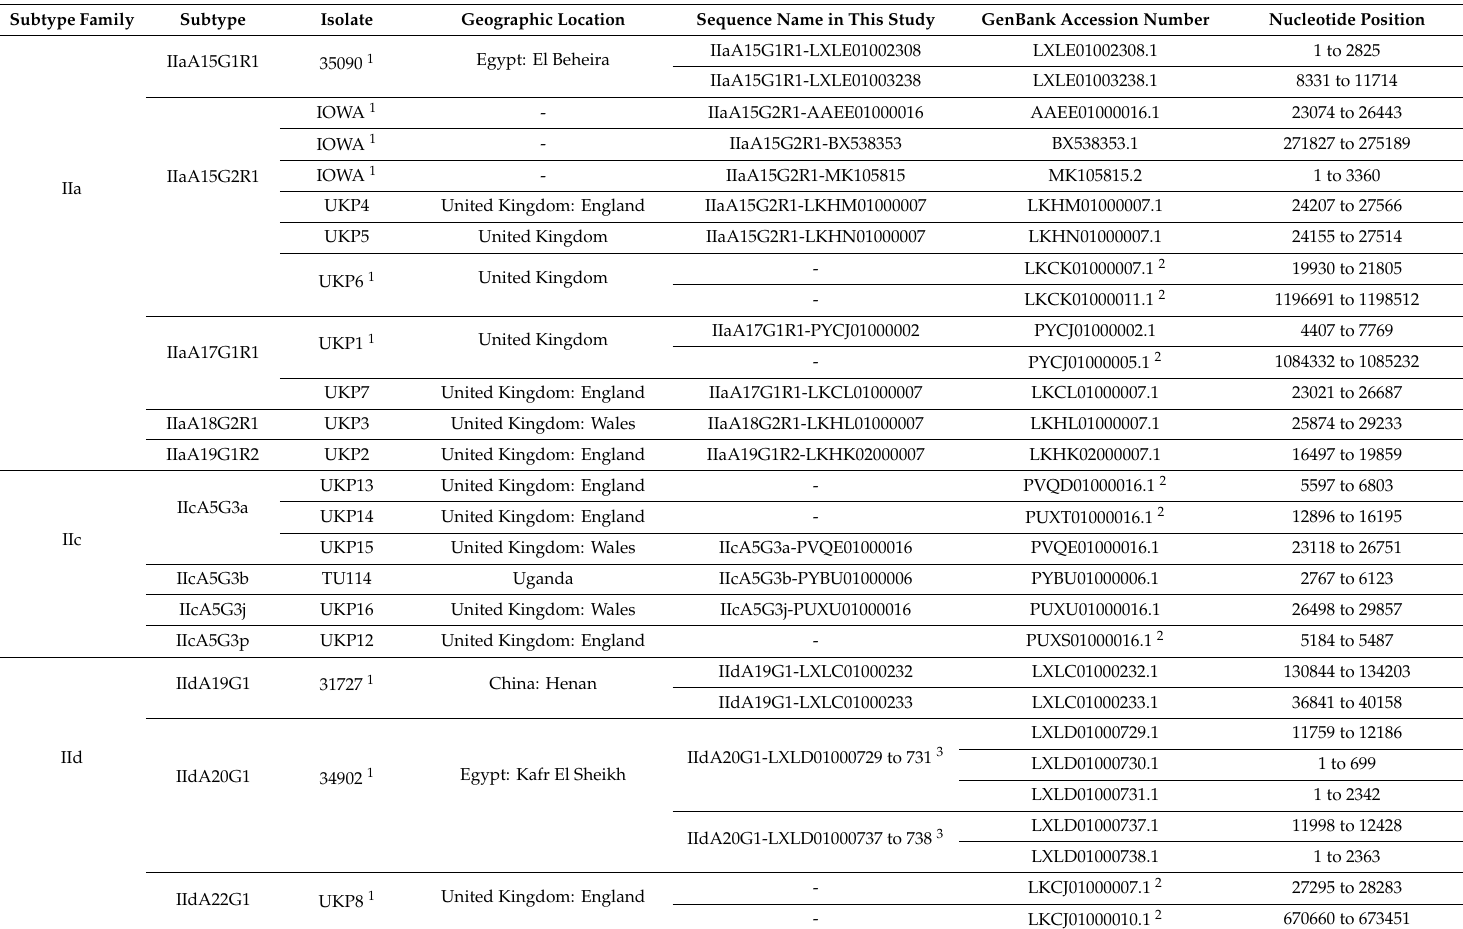
Table 3. Twenty-six sequences of the cgd6_5520-5510 gene in Cryptosporidium parvum downloaded from the GenBank